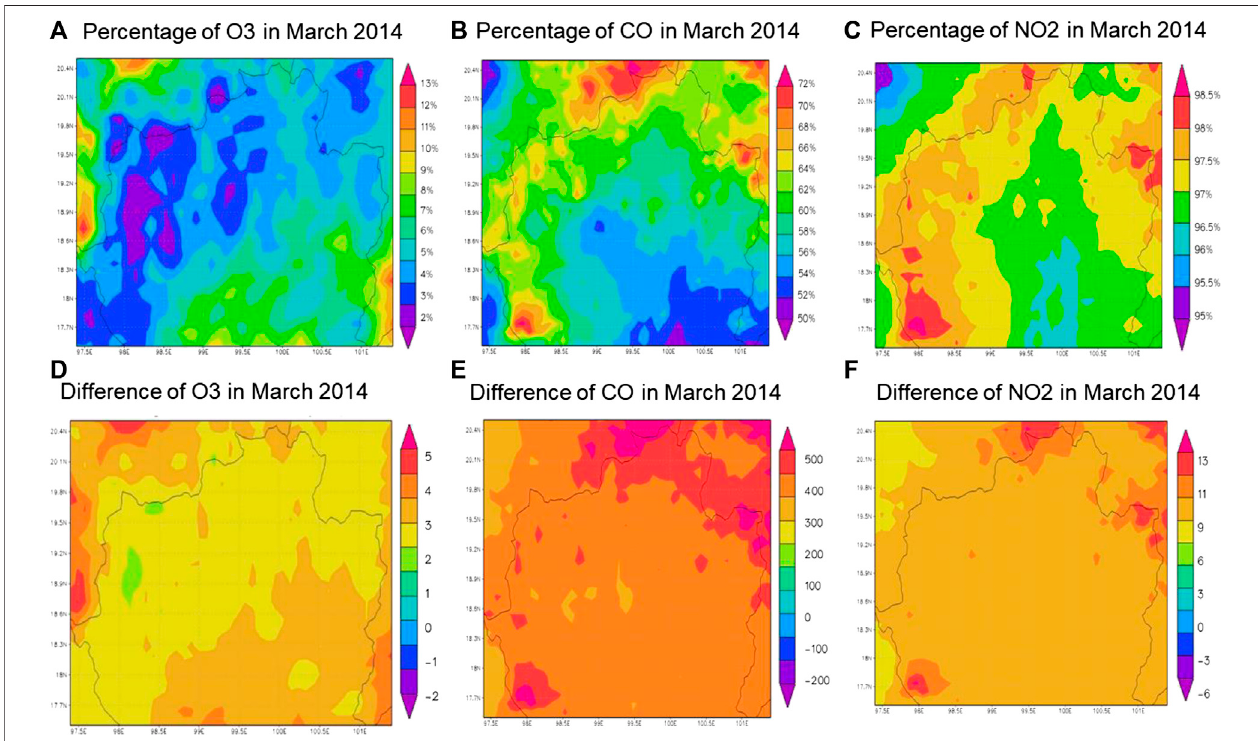
FIGURE 2 | Percentage (upper panel) and absolute (bottom panel) differences in O 3 (A and D) , CO (B and E) , and NO 2 (C and F) concentrations between the two WRF-Chem simulations with and without biomass burning